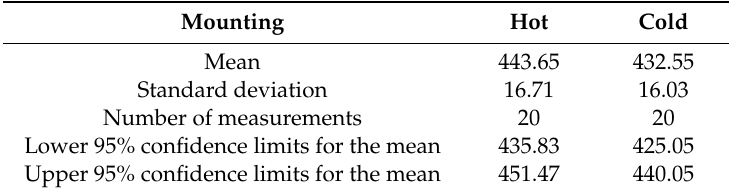
Table 2. HV10 hardness after hot- and